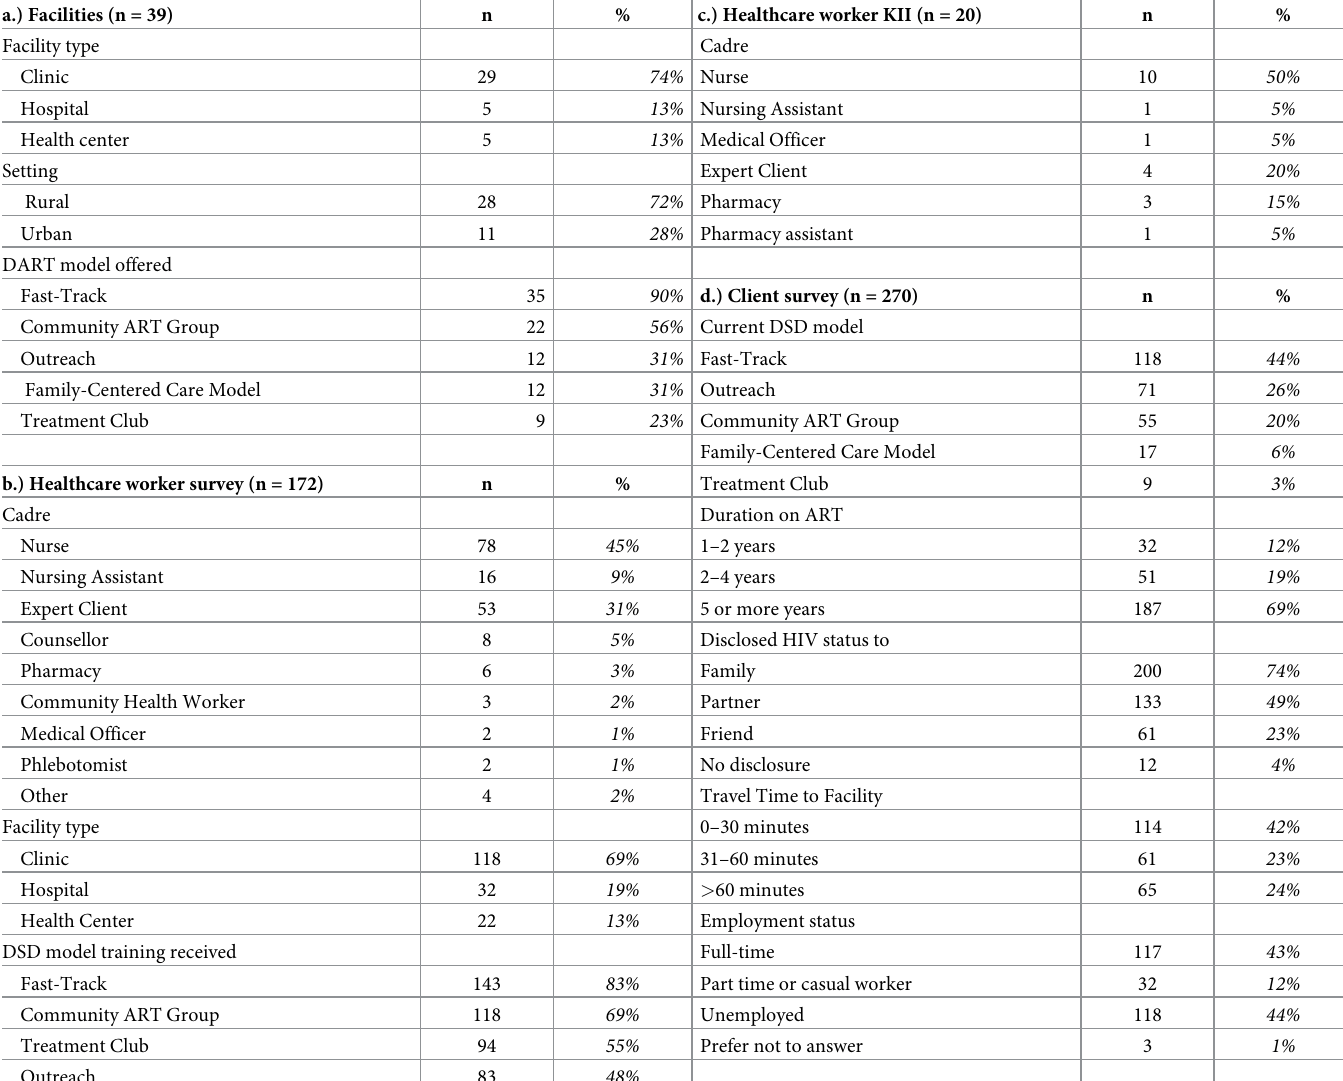
Table 1. a-d. Characteristics of facilities, survey respondents and key informant interview (KII)